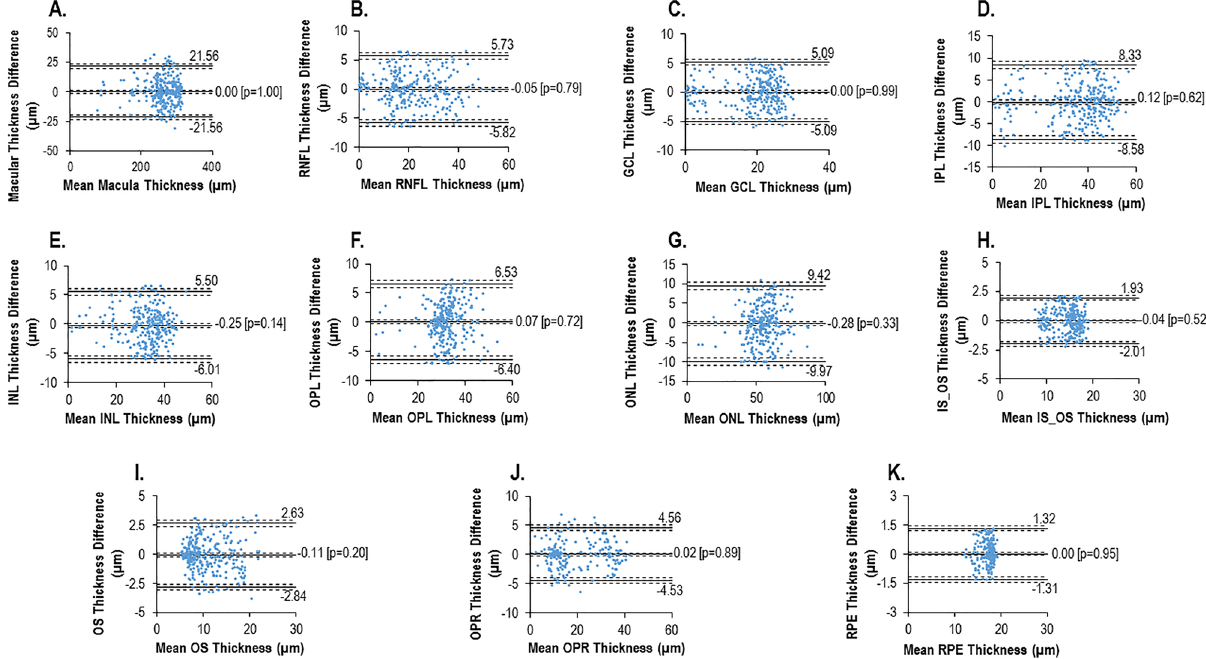
Figure 2. Bland–Altman plots examining the repeatability of the retinal thickness measures from two repeated scans within a session from each marmoset where the difference between the repeated scans is plotted against the mean of the two repeated scans. The solid lines in each plot indicates the mean difference and limits of agreement (LOA: ± 1.96 times the SD of the mean difference), while the dash lines represents the 95% upper and lower confidence interval of the solid lines (mean difference and LOA).( A ) Overall retinal thickness, ( B ) RNFL, ( C ) GCL, ( D ) IPL, ( E ) INL, ( F ) OPL, ( G ) ONL, ( H ) IS/OS, ( I ) OS, ( J ) OPR + SRS, and ( K ) RPE.